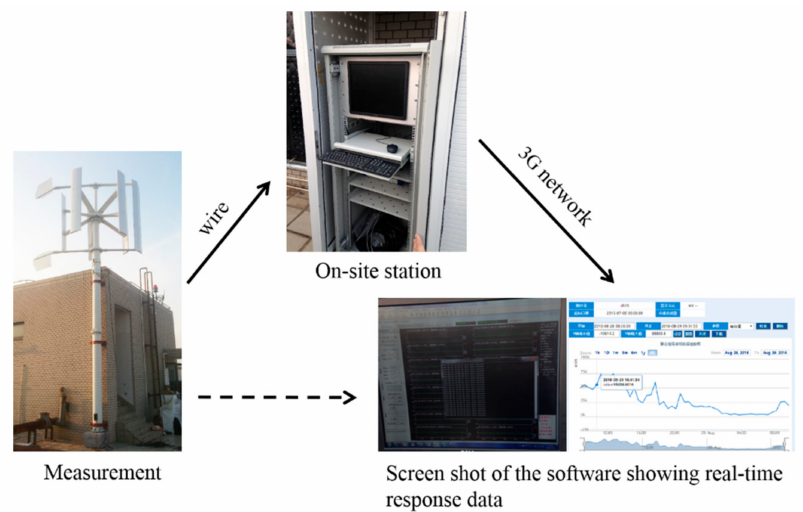
Figure 5. Monitoring setup of the VAWT tower.